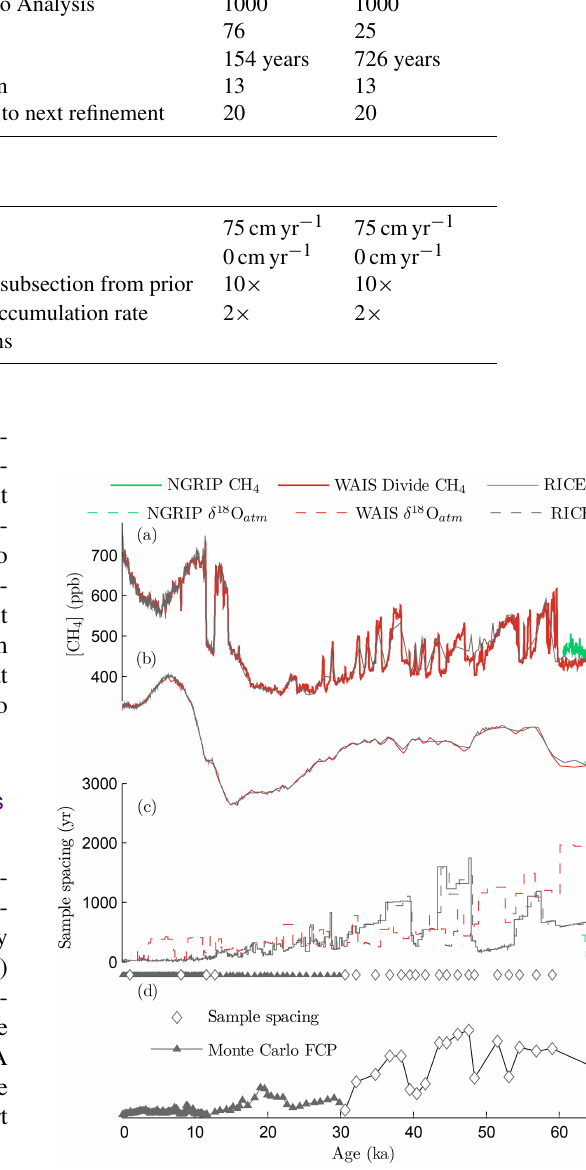
Table 2. Model Parameters used for optimized correlation routine. Code for routine can be found in the Supplement. Variable Description Model